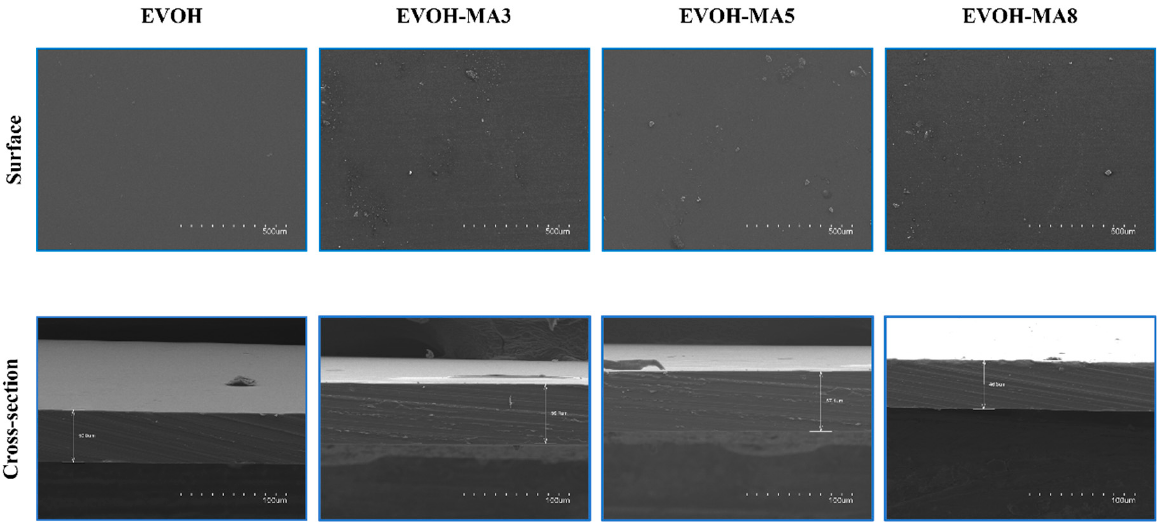
Figure 3. SEM micrographs of sample surfaces and cross sections (×100 and ×500, respectively.).